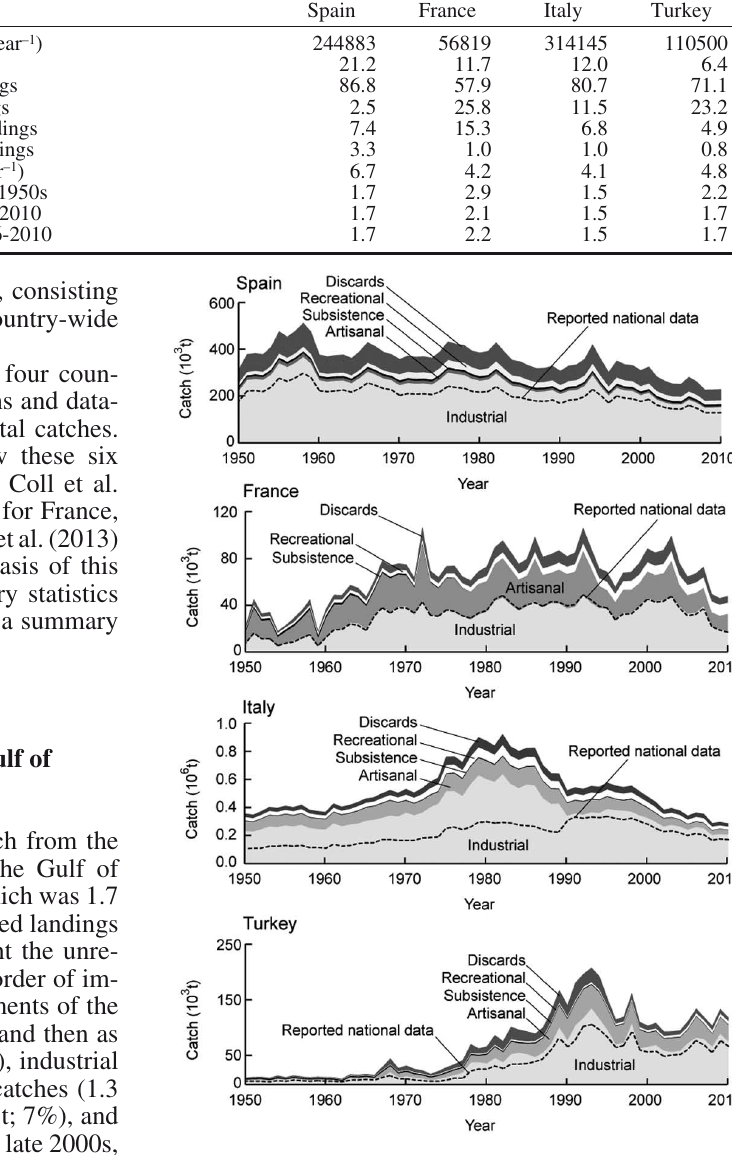
Table 2. – Summary of results from the reconstructed catches for Mediterranean Spain (from Coll et al. in press), France (from Bultel et al. in press), Italy (from Piroddi et al. in press) and Turkey (Ulman et al. 2013). Results